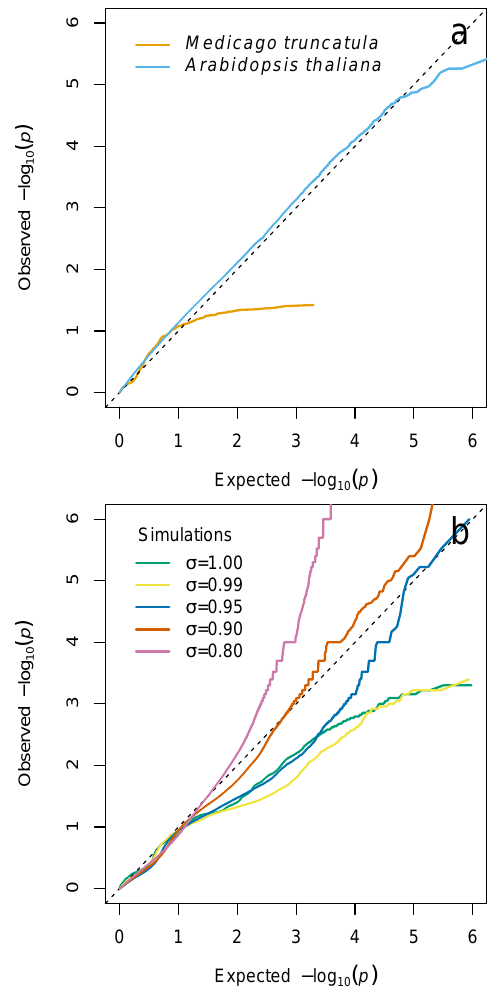
Figure 12 – Departure from expectations of the p -value distribution for Medicago trun- catula genome scan. (a) QQ plots for Medicago truncatula (this study) and Arabidopsis thaliana (Fig. S21 Frachon et al., 2017). For M. truncatula , p -values estimated for 987 SNP loci that were polymorphic in the sample with a global minor allele frequency higher than 0.05 (Table 2). Null model considered N e = 42 and σ = 0.99 . (b) QQ plots for simulations under a scenario of adaptation from new mutations in a population of N = 500 diploid individuals sampled twice with τ = 25 generations between samples and different rates of selfing, σ . A new advantageous mutation appears at generation t = 0 with coefficient of selection s = 0.5 . Samples are made of 50 diploid individuals genotyped at 10 000 bial- lelic markers (including the locus under selection). The plot consider the distribution of p -values from 100 simulation